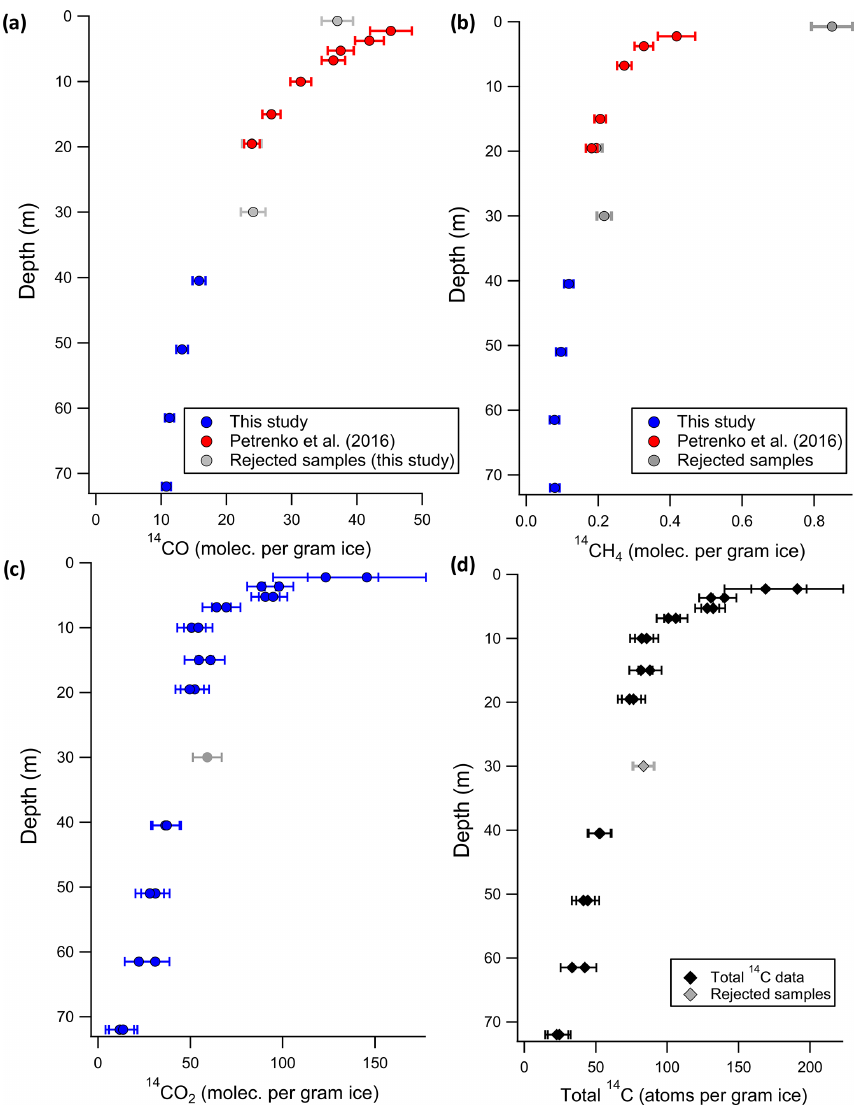
Figure 3. (a) Measured 14 COmolec. per gram of ice after all corrections. (b) Measured 14 CH 4 molec. per gram of ice after all corrections. (c) Measured 14 CO 2 molec. per gram of ice after all corrections. (d) Total measured 14 Catoms per gram of ice. This represents the sum of 14 CO, 14 CH 14 CO 4 , and sublimation-based 2 measurements. All error bars shown in this figure are 95%